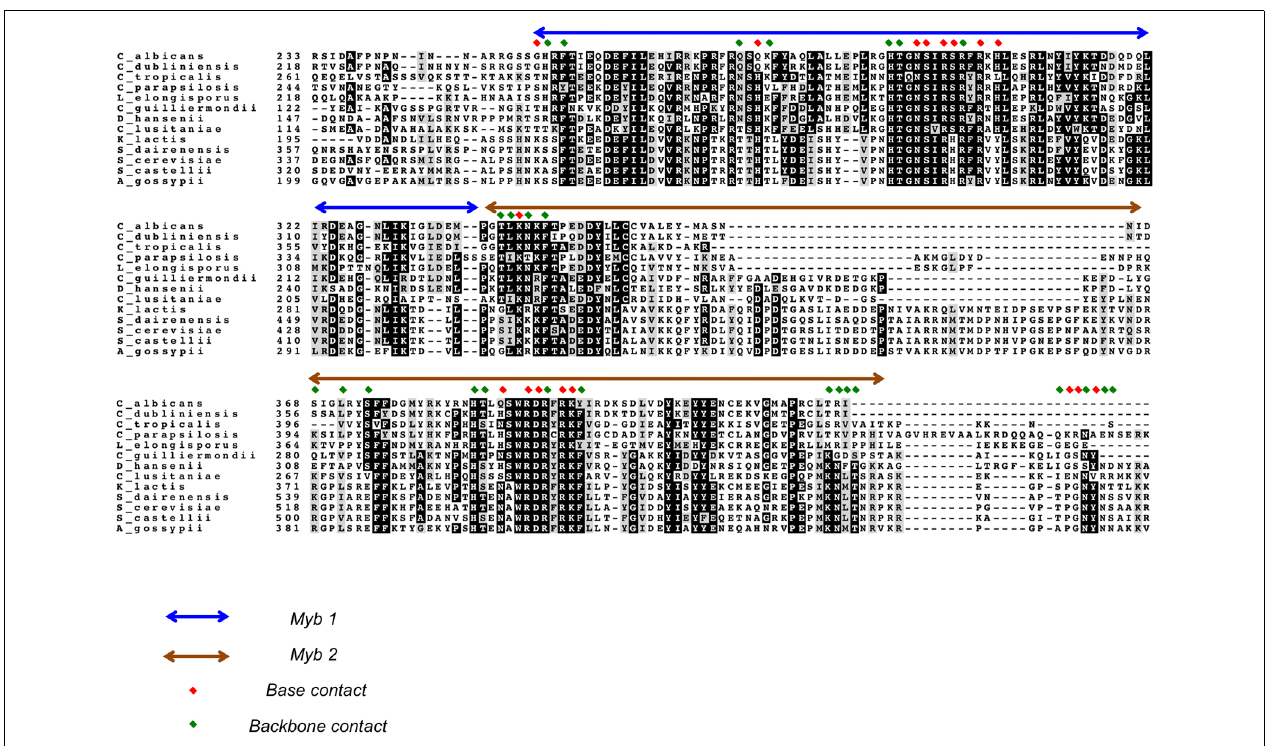
FIGURE 3 | An alignment of Rap1 DBDs showing the variable extent of sequence conservation of residues implicated in DNA contacts. An alignment of the DBDs of selected Saccharomycotina Rap1 homologs is displayed. The first and second Myb motifs are indicated by blue and brown